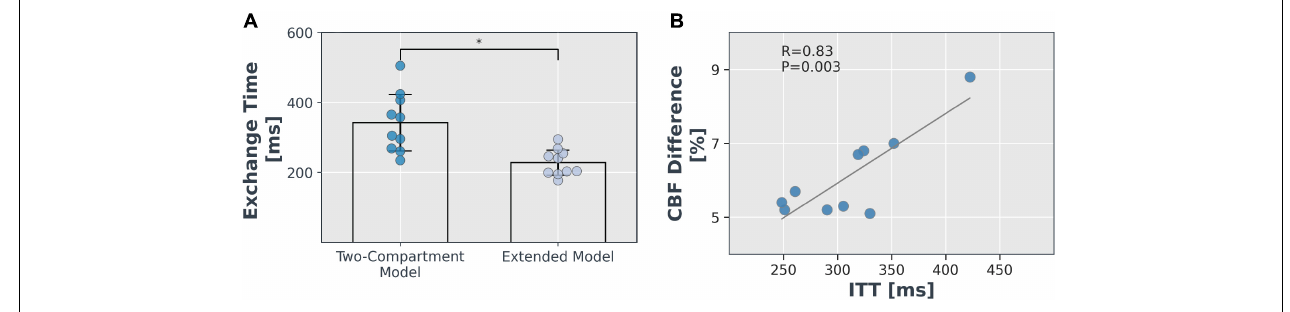
FIGURE 8 | Comparison of models. (A) Mean grey matter exchange time with associated error (standard deviation) estimated with the two models ( ∗ P < 0.05). (B) The correlation of perfusion difference estimated with the two models relative to two-compartment model and ITT parameter.